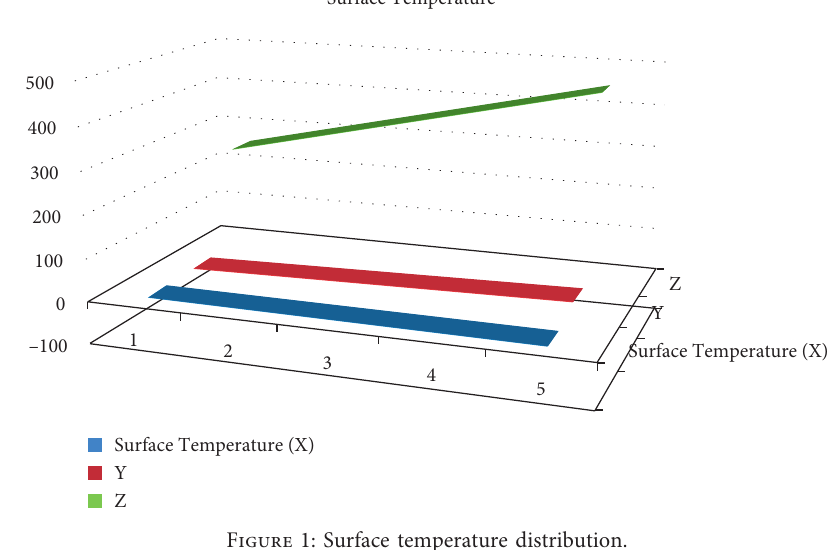
Figure 1: Surface temperature distribution.